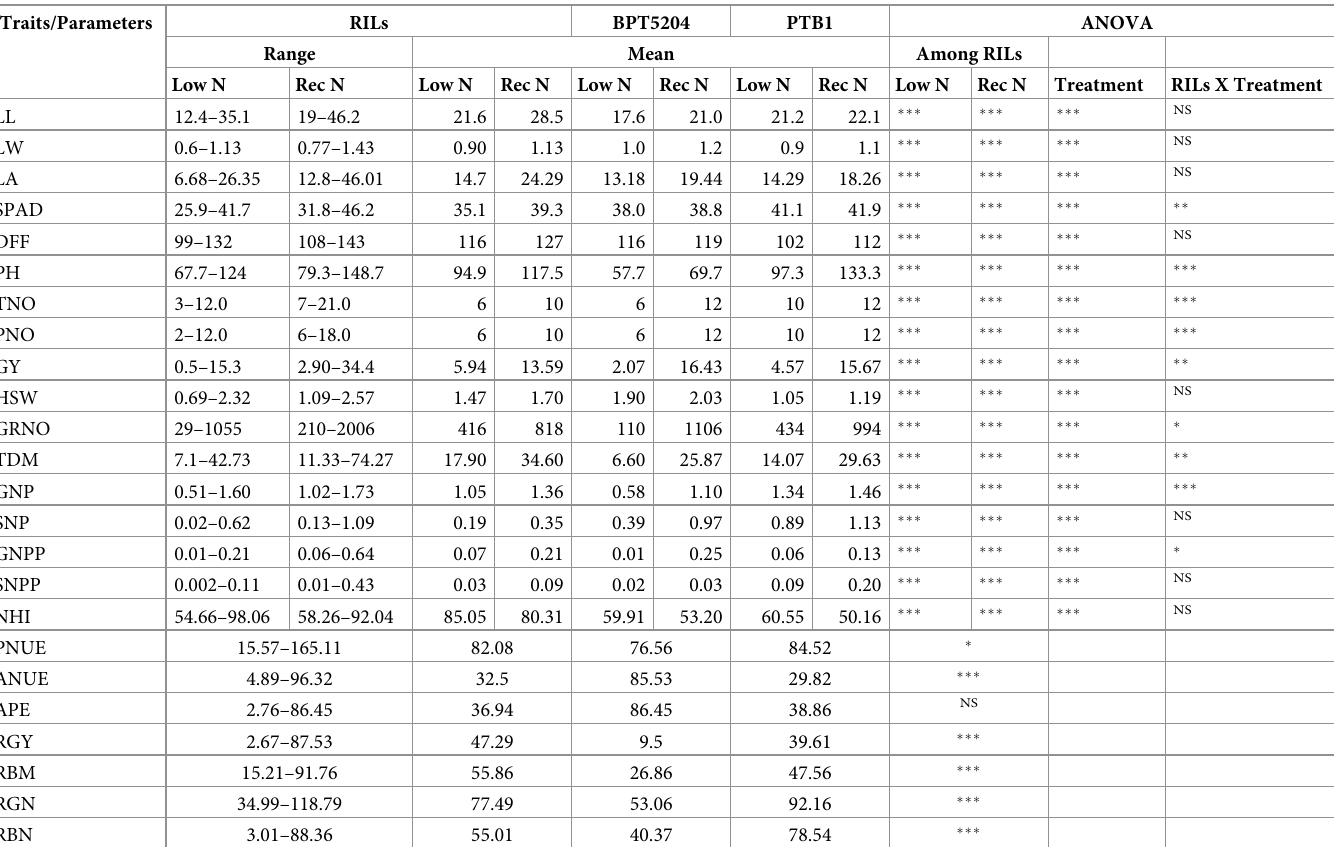
Table 2. ANOVA for leaf, agro-morphological, yield and yield related, N content and N use efficiency indices of parents and RILs in dry season.